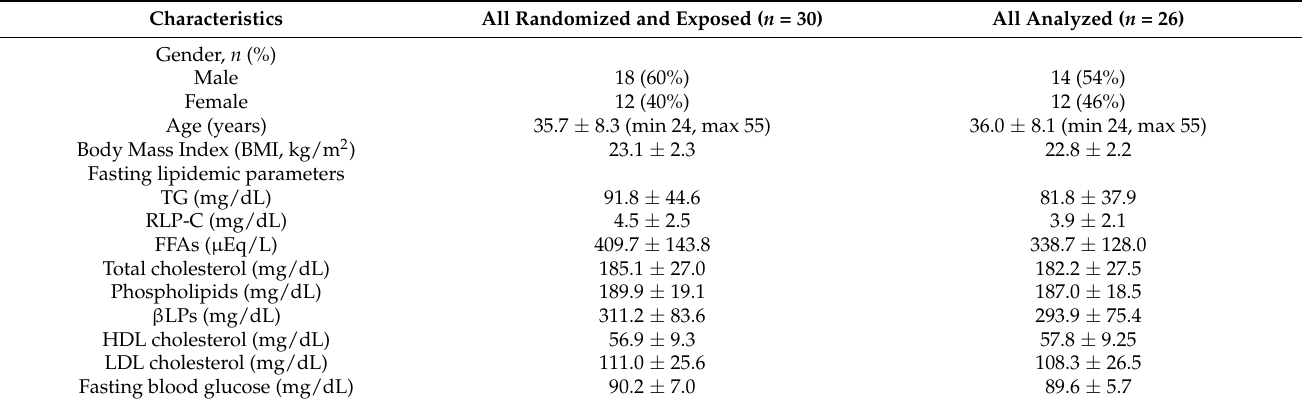
Table 3. Baseline characteristics of all randomized and exposed participants.